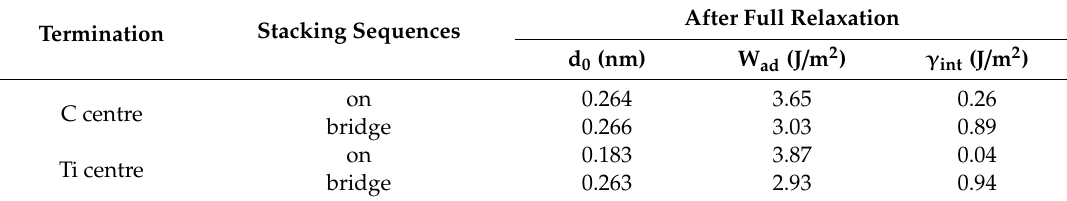
Table 4. Interfacial distance, adhesion work and interfacial energy of TiC/Fe after full relaxation.